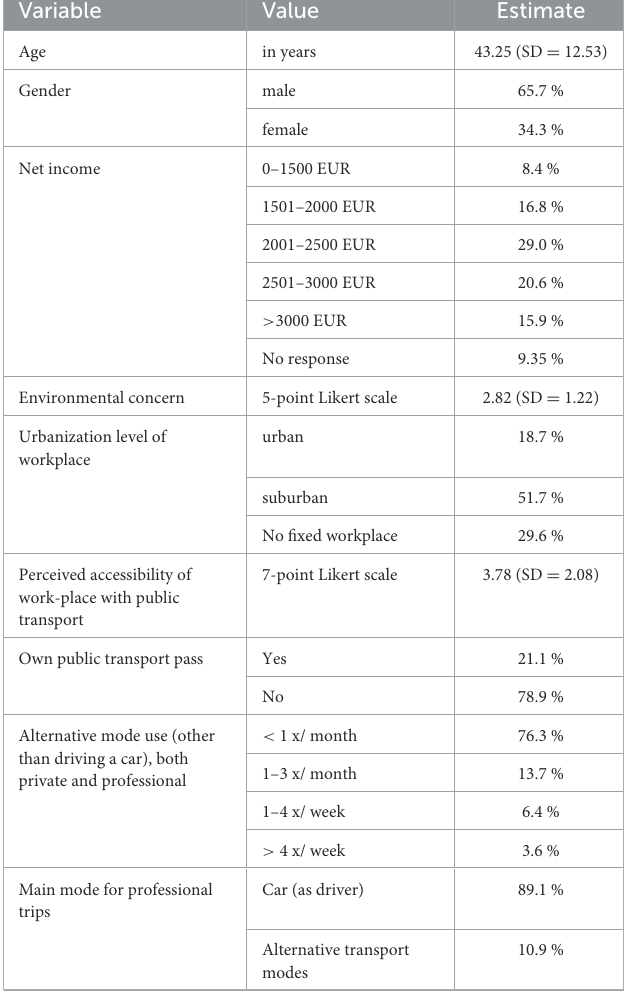
TABLE 2 Sample characteristics ( n =